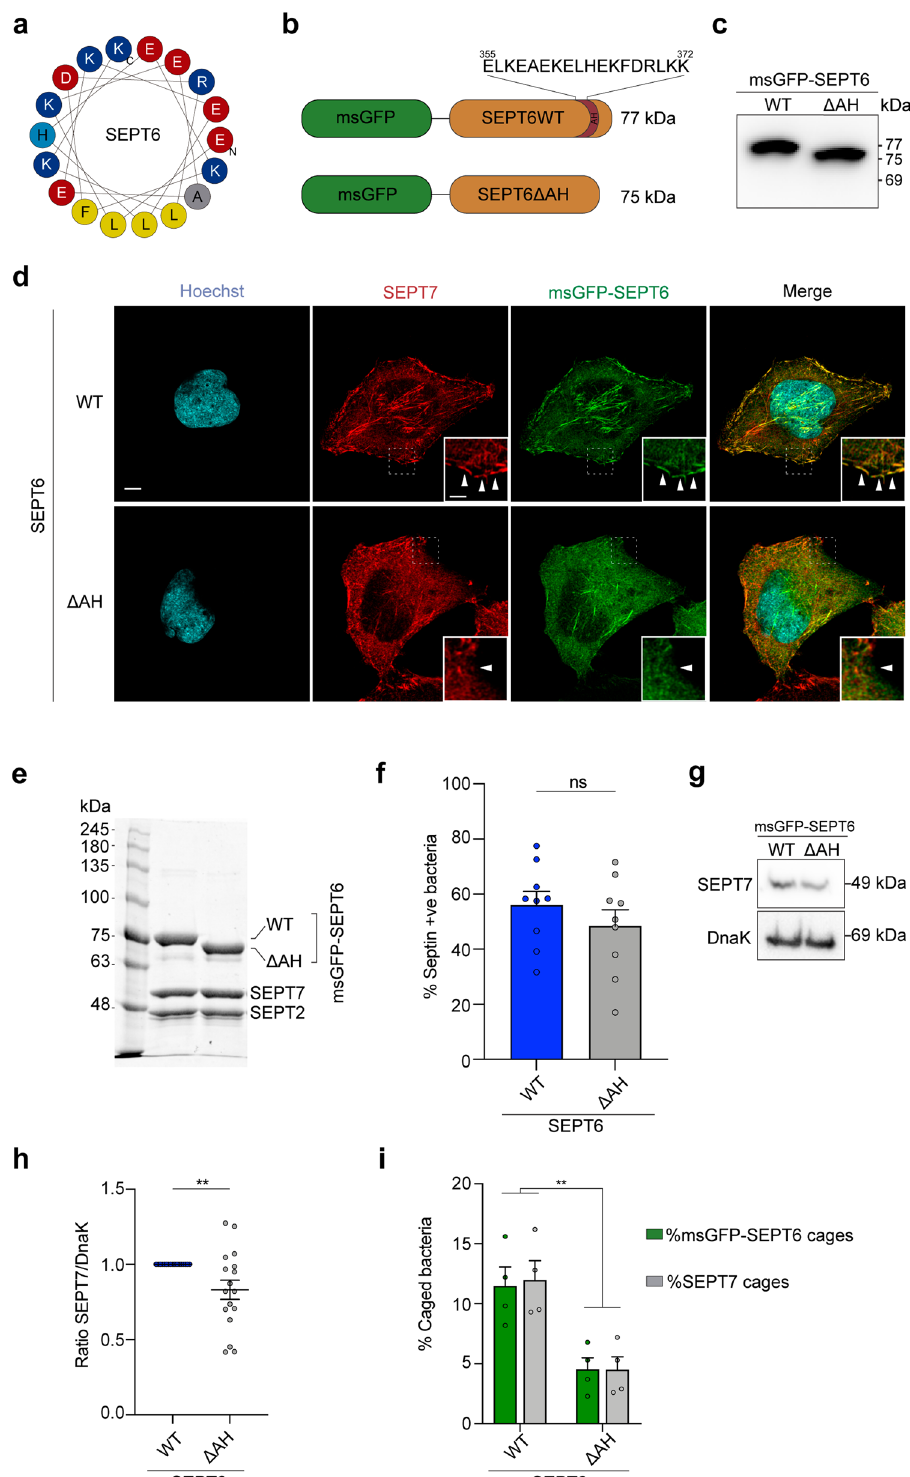
mutants lacking O-antigen ( Δ rfaL ) or O-antigen and outer core components of the LPS ( Δ galU ) (Supplementary Fig. 8a), and tested for septin recruitment in our in vitro reconstitution system. Consistent with a role for bacterial LPS in preventing septin cage entrapment, S. fl exneri Δ rfaL and Δ galU are recognized by septins as ef fi ciently as S. fl exneri Δ rfaC in vitro (Supplementary Fig. 8b). Septin recruitment to S. fl exneri Δ galU is similar to that of S. fl exneri Δ rfaC , i.e., the entire